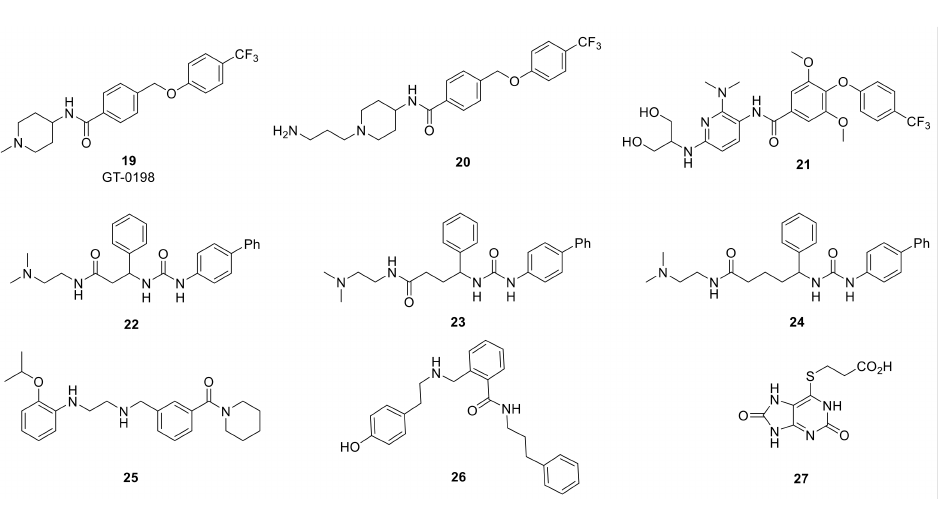
Figure 7. Miscellaneous GlyT2